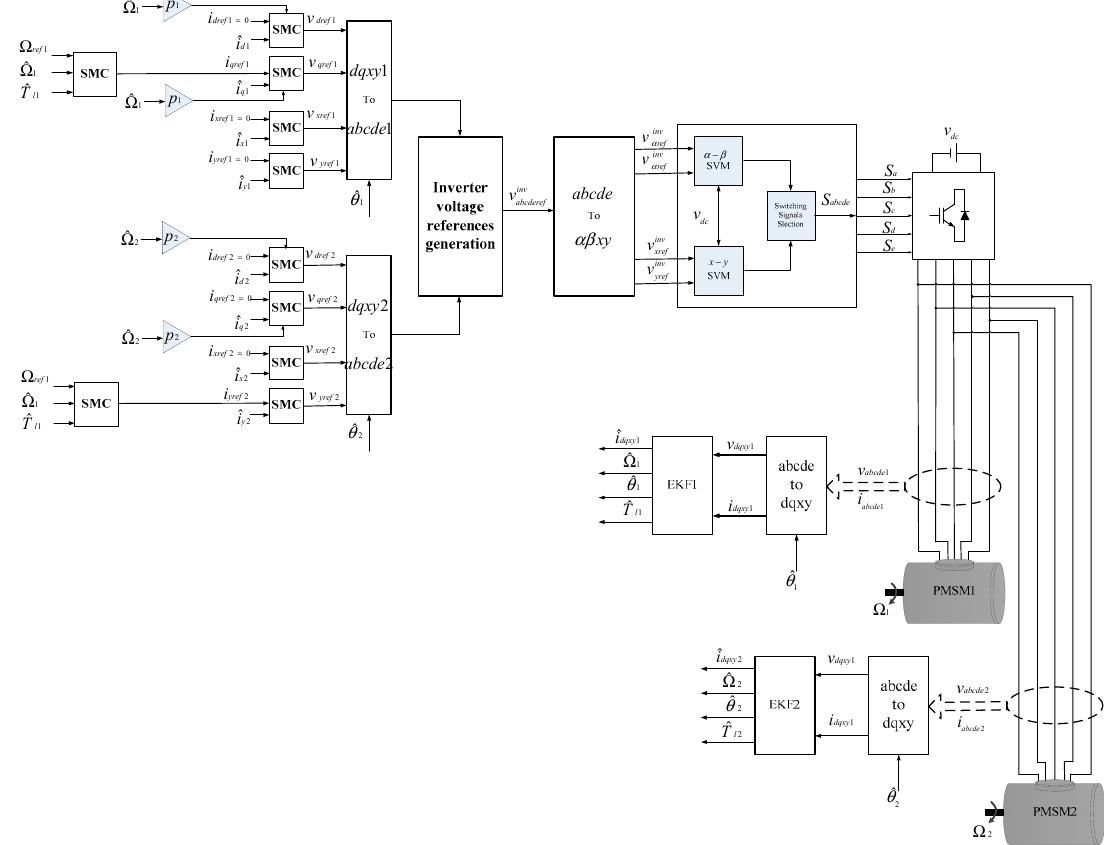
Figure 2. Sensor-less SMC of parallel-connected two five-phase PMSMs drive system.